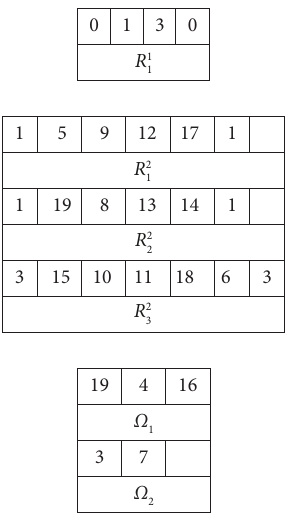
Figure 2: Te solution representation example of